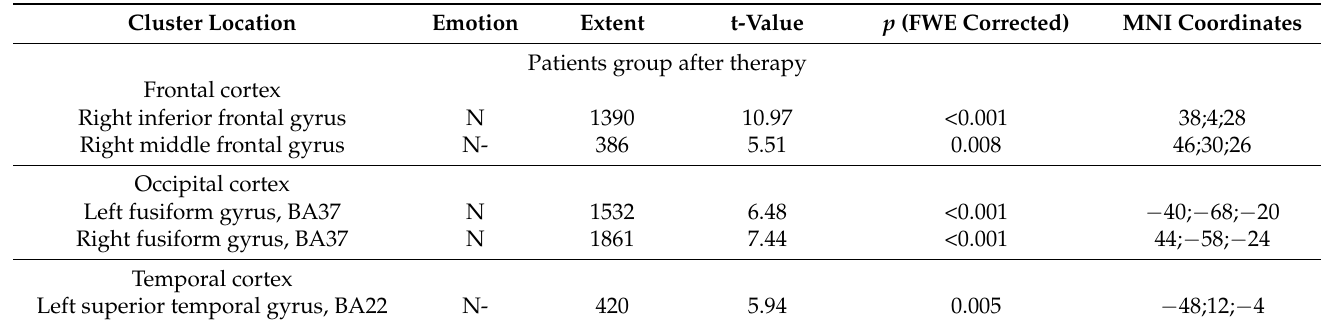
Table 3. Cluster and peak statistics for brain activations during facial emotion recognition in patients after antidepressant